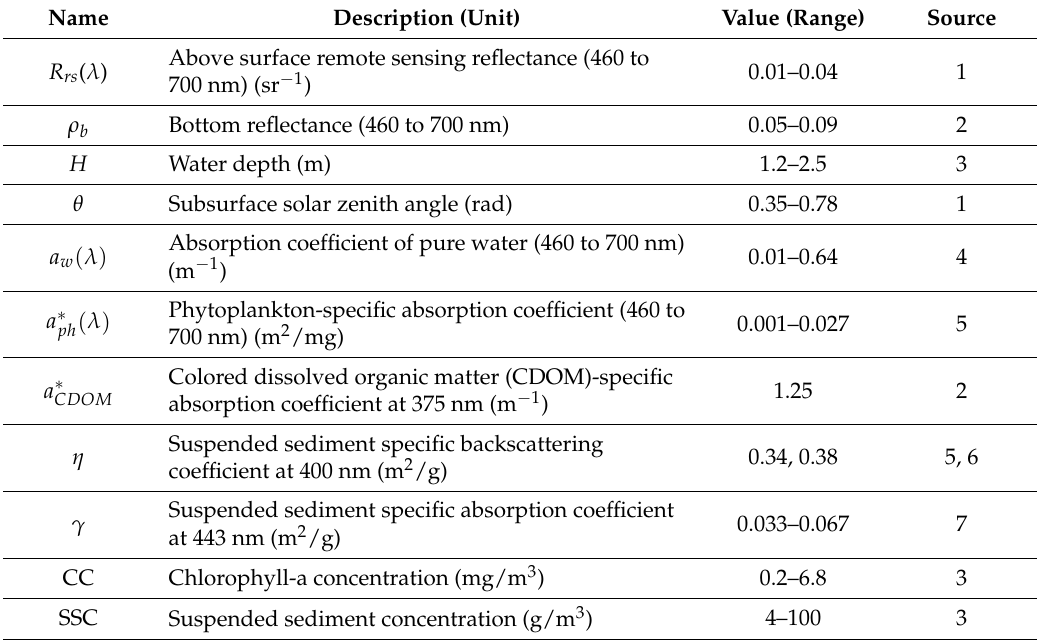
Table 2. List of variables used in Equations